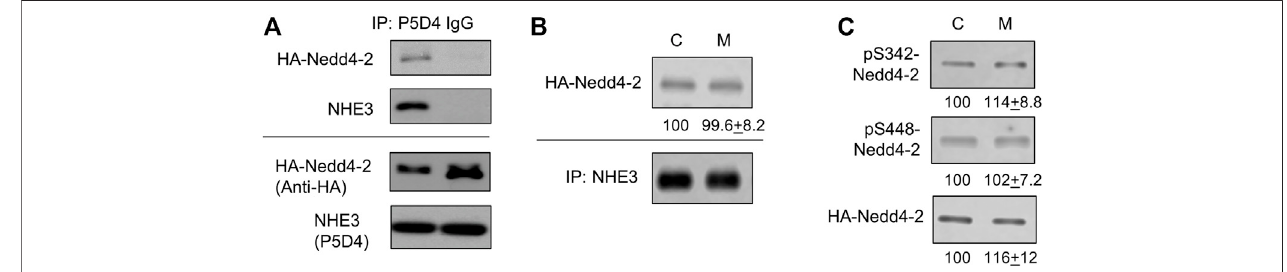
FIGURE 6 | The interaction of Nedd4-2 with NHE3 is not enhanced by metformin. (A) Caco-2bbe cells expression NHE3 was lysed and immunoprecipitated with anti-VSVGP5D4antibodyorIgG.HA-Nedd4-2co-immunoprecipitatedinthepresenceofP5D4butnotIgG. (B) Co-immunoprecipitationofHA-Nedd4-2andNHE3are shown. NHE3 was immunoprecipitated from Caco-2bbe cells untreated (Con) and treated with 1 mM metformin (M) for 30 min. Co-immunoprecipitated Nedd4-2 was blotted with anti-HA antibody. Representative blots from three independent experiments are shown. Numbers below each blot represent quanti fi cation of protein bands relative to control. n = 3. (C) Phosphorylation of Nedd4-2 at S342 and S448 was determined using phosphorylation speci fi c antibodies under the conditions descried above. Representative blots from three independent experiments are shown. Numbers below each blot represent quanti fi cation of protein bands relative to control. n =